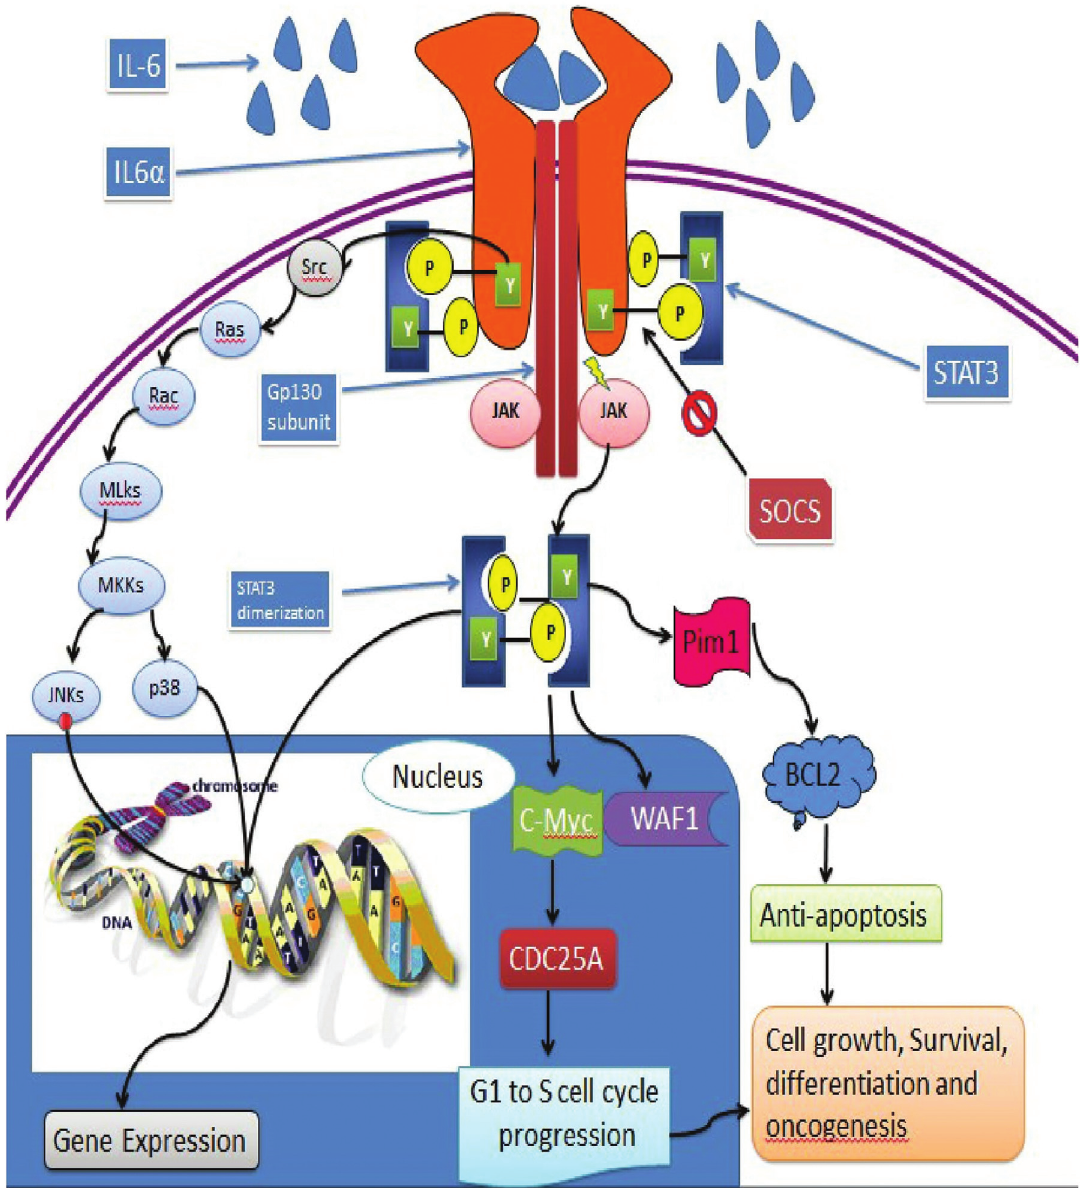
Figure 2 - Polypeptides bind to their associated receptors and trigger the tyrosine (Tyr) kinase (TK) events of the receptors, Src or JAKs. Underlying STAT-3 action is the stimulated receptor for phosphorylation on specific Tyr residue by TKs that causes STAT-3:STAT-3 dimerization and stimulation.